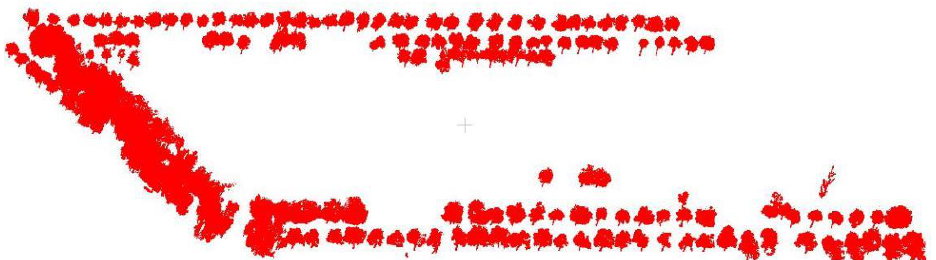
Figure 11. Single tree extraction results.